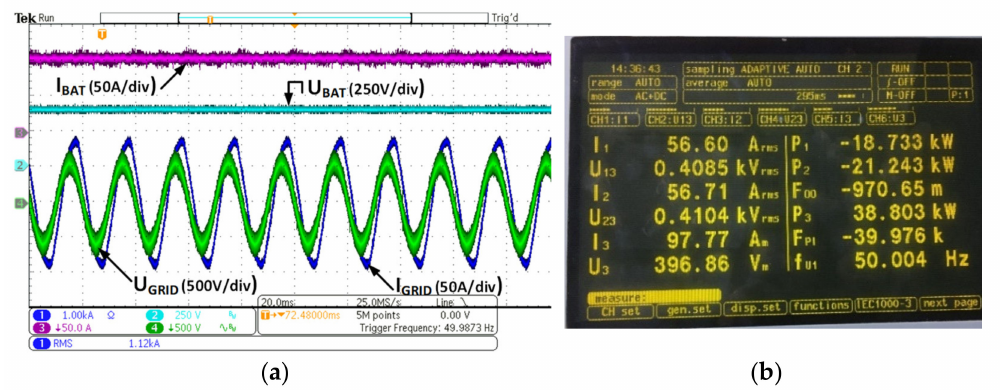
Figure 15. Operation of the bidirectional charger under nominal conditions—steady state, charging mode: ( a ) current and voltage waveforms, from the top: battery current (purple), battery voltage (light blue), AC phase current (dark blue), AC line-to-line voltage (green); ( b ) printed screen from the LEM NORMA power analyzer.